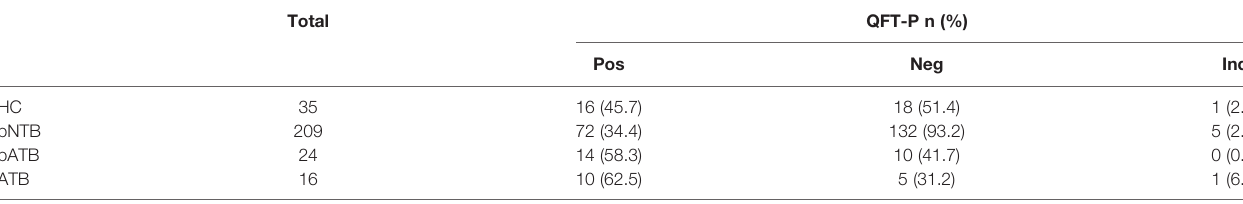
TABLE 3 | QuantiFERON-TB Gold-Plus assay results regarding the study participants clinical group. Total